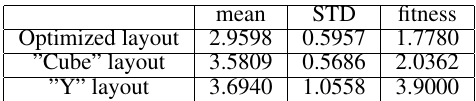
Table 2. Four base stations different layout methods